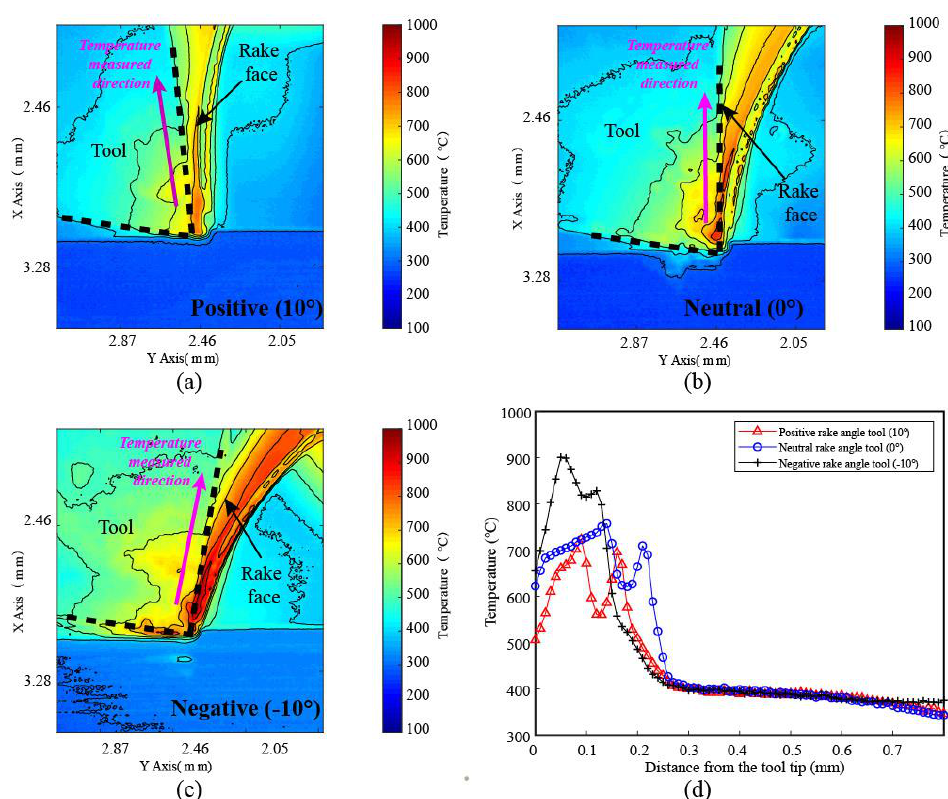
Figure 8. The IR image obtained in the orthogonal cutting of Inconel 718 with different rake angle tools. ( a ) Thermal distribution for positive rake angles, ( b ) thermal distribution for neutral rake angles, ( c ) thermal distribution for negative rake angles and ( d ) the temperature gradient along rake face of different geometry tools.